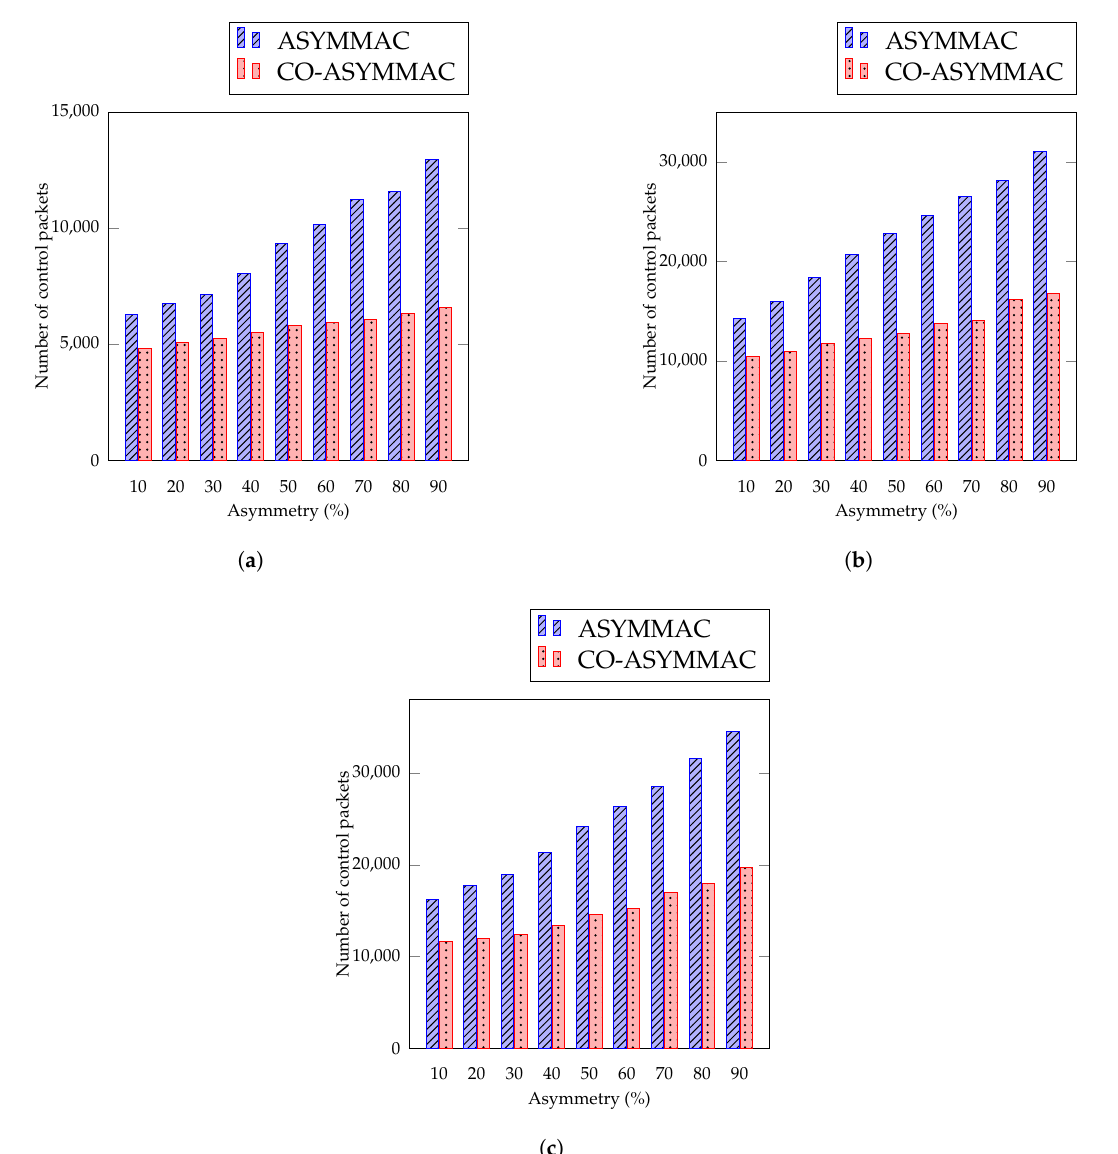
Figure 15. Control Packet Overhead ( a ) for 27 nodes ( b ) for 54 nodes ( c ) for 90